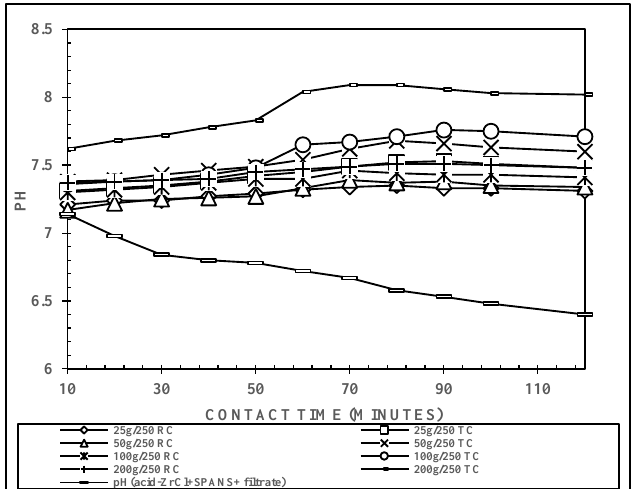
Figure 5: Plot of fluoride concentration left in the groundwater with the time of contacts.